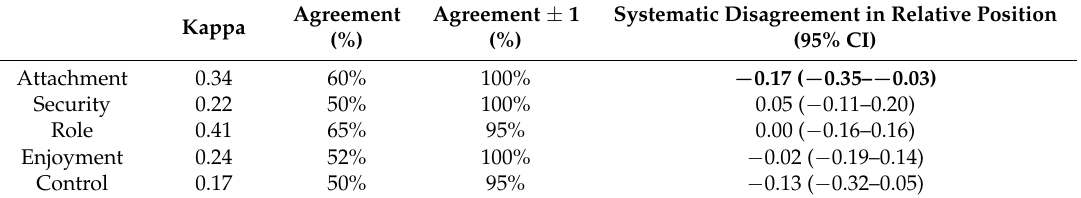
Table 1. Test–retest reliability of the ICECAP-O on item level in 70-year-olds ( n = 39).